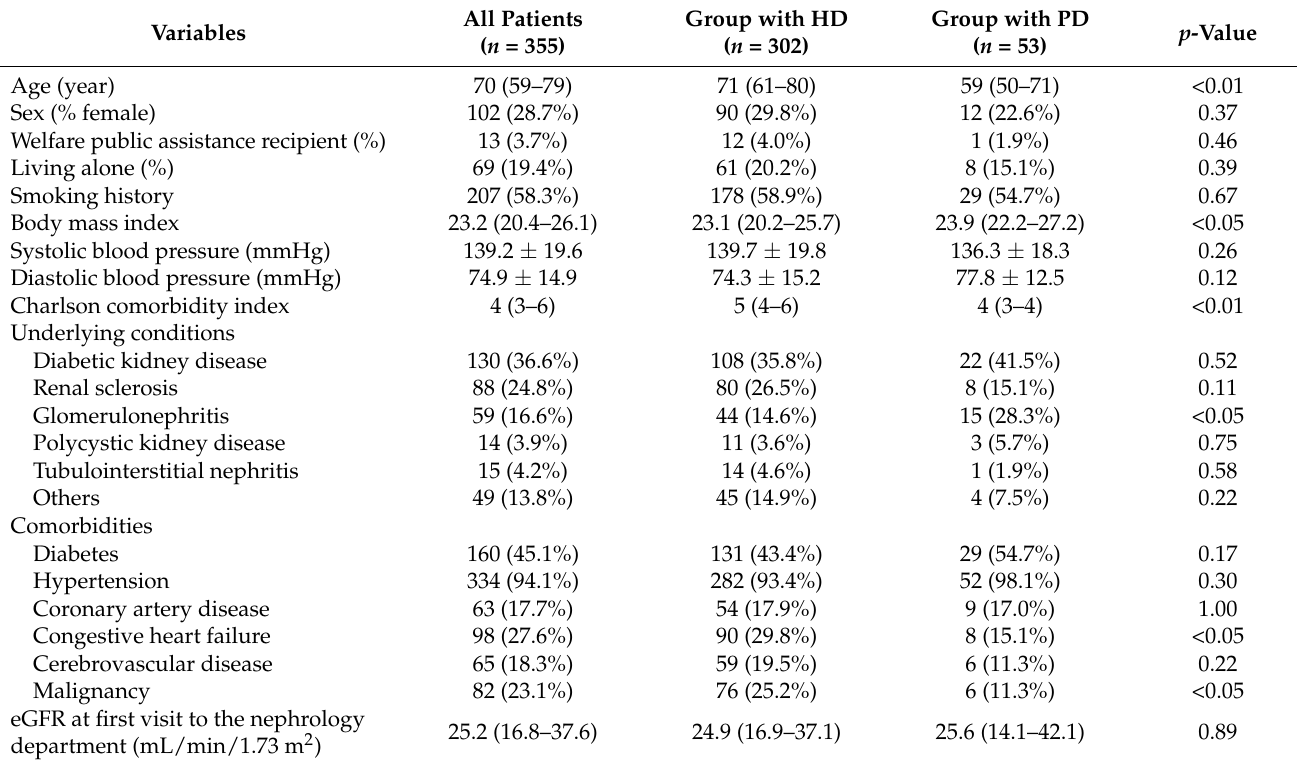
Table 1. Patients’ baseline characteristics in groups with HD and